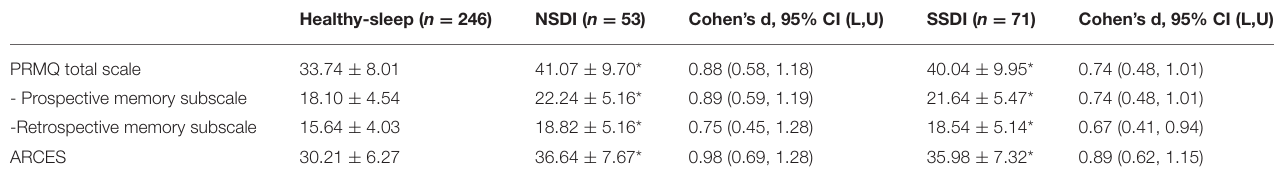
TABLE 3 | Means and standard deviations for the self-reported cognition assessments (PRMQ and ARCES) for the healthy sleepers, those with NSDI, and